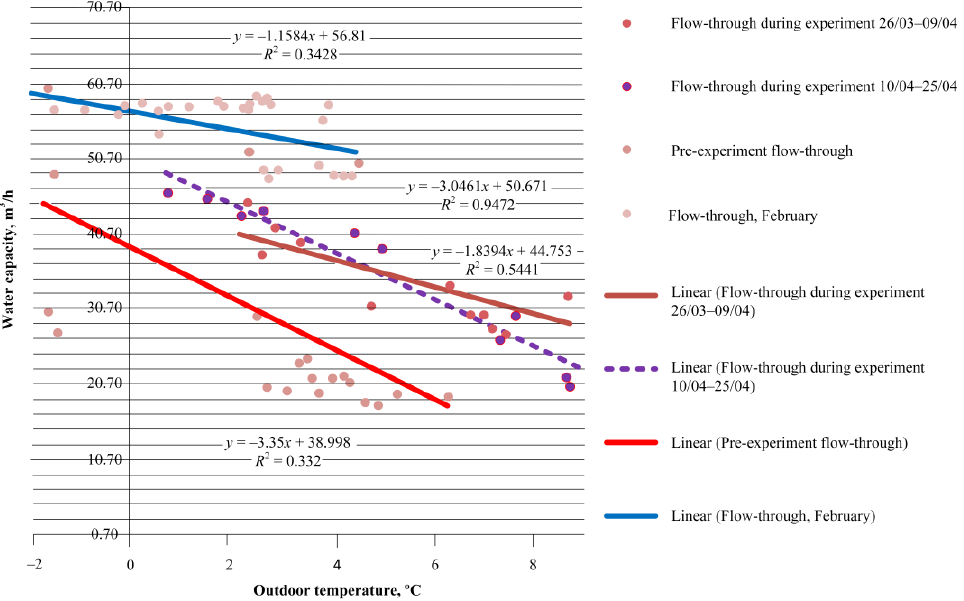
Fig. 5. Changes in the daily mass flow rate (m 3 /day) during the pre-experiment and